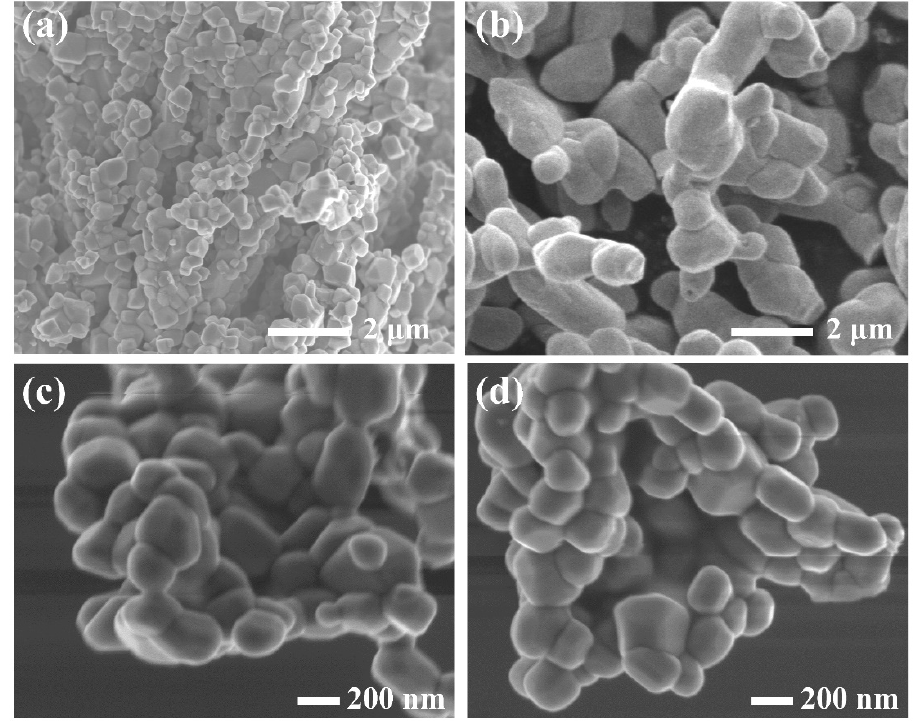
Figure 2. SEM images of ( a ) SrTiO 3 and ( b ) LaCrO 3 . High-magnification SEM images of ( c ) SrTiO 3 and ( d ) SrLaTiCrO-0.10.